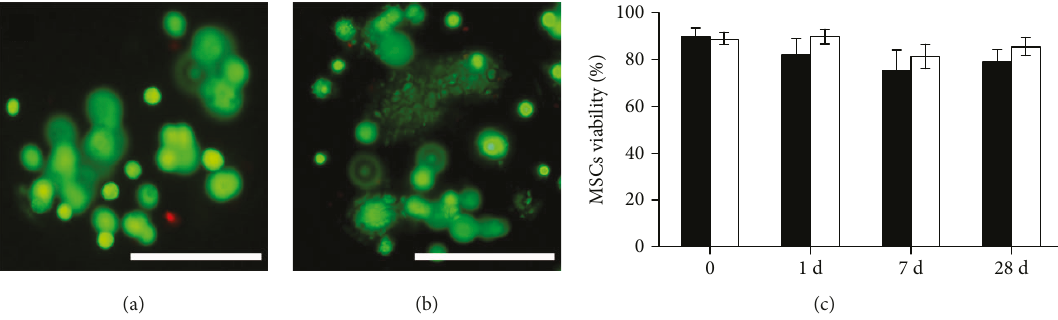
Figure 2: In vitro MSC viability assessment after encapsulation. (a, b) Photomicrographs of unlabeled microcapsules (a) and PFOBCaps (b) containing rabbit MSCs where live cells were stained green and dead cells were stained red. (c) Quantitative MSC viability in unlabeled (open bars) and PFOBCaps (black bars) at 0, 1, 7, and 28 days after encapsulation. The viability of encapsulated MSCs in both microcapsules did not di ff er signi fi